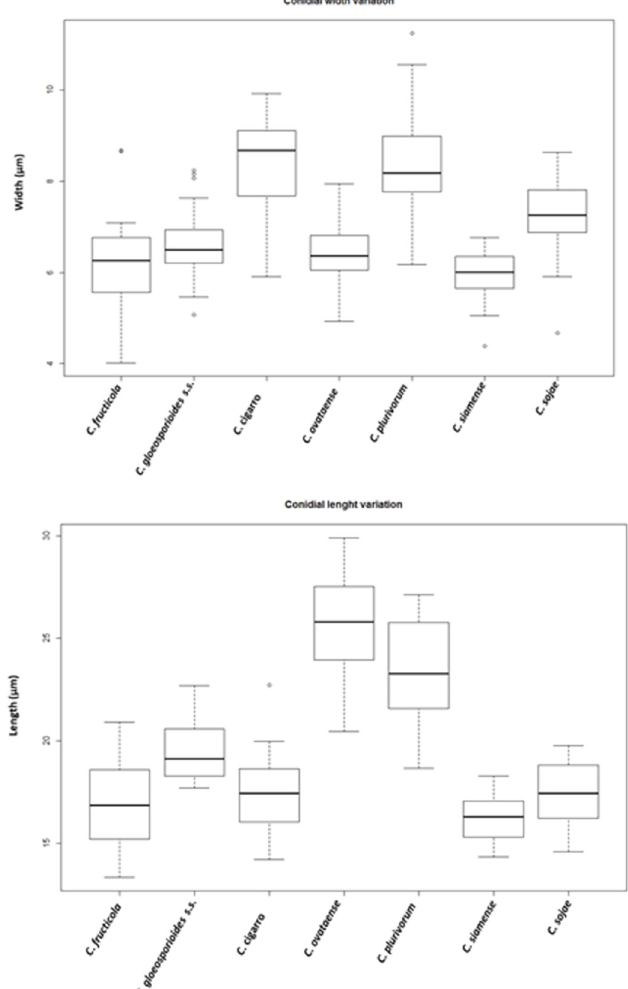
Fig 15. Box plots showing the variation in length and width of conidia produced in